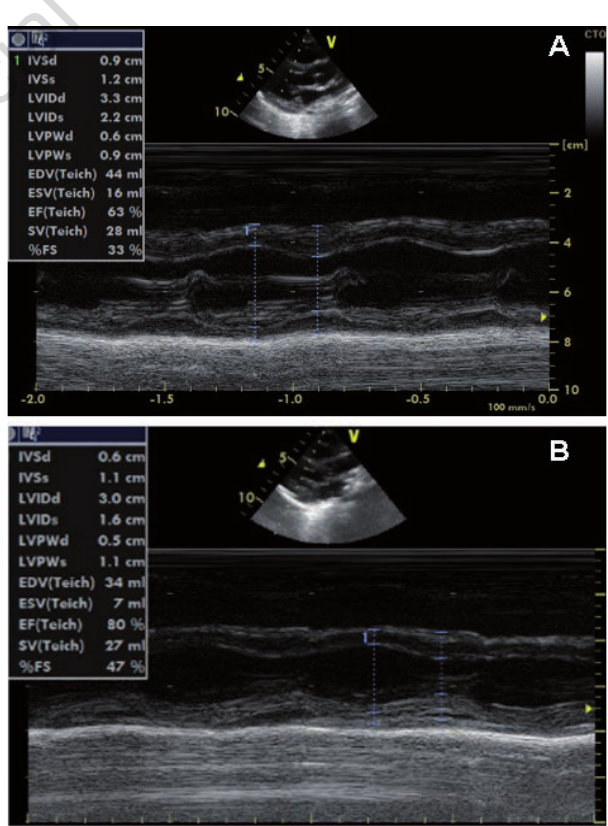
Figure 16. A) A 4-year old girl with mucopolysaccharidosis type I. Increased thickness of interventricular septum (9 mm); B) Same patient after 7-month enzymatic replacement therapy (interven- tricular septum 6